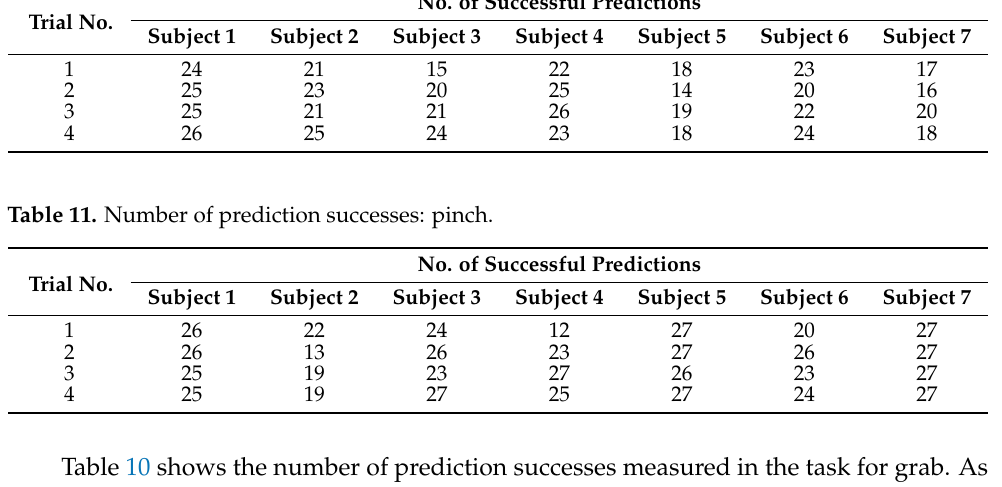
Table 10. Number of prediction successes: grab. Trial No.